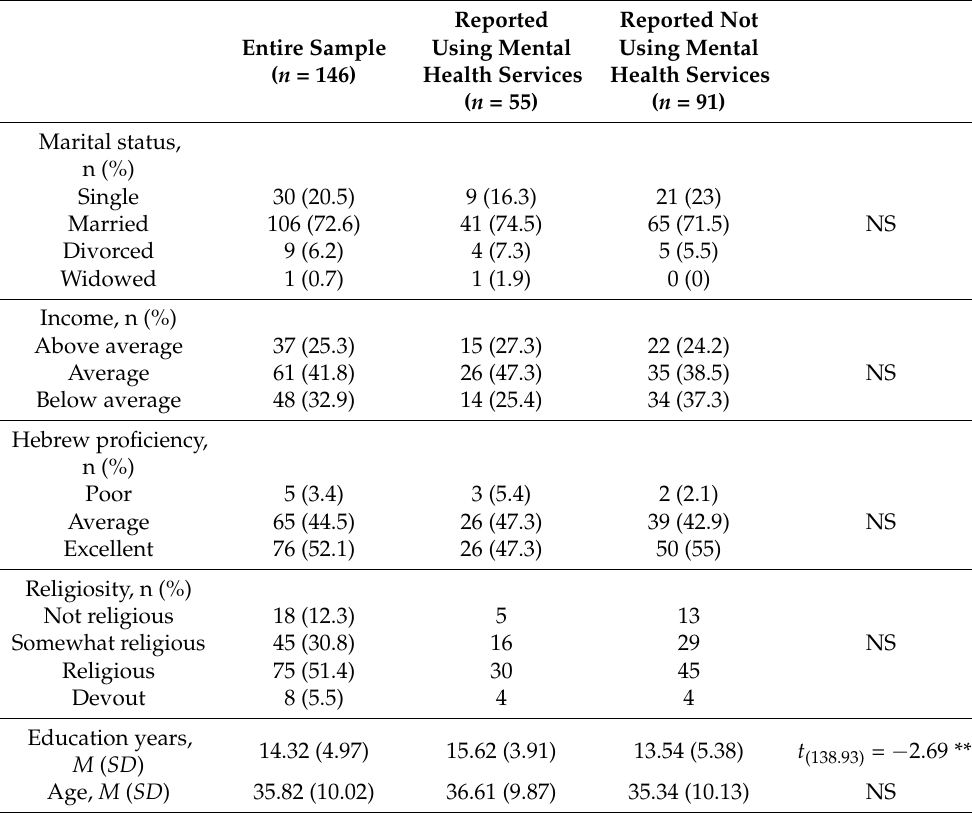
Table 1. Participants’ Sociodemographic